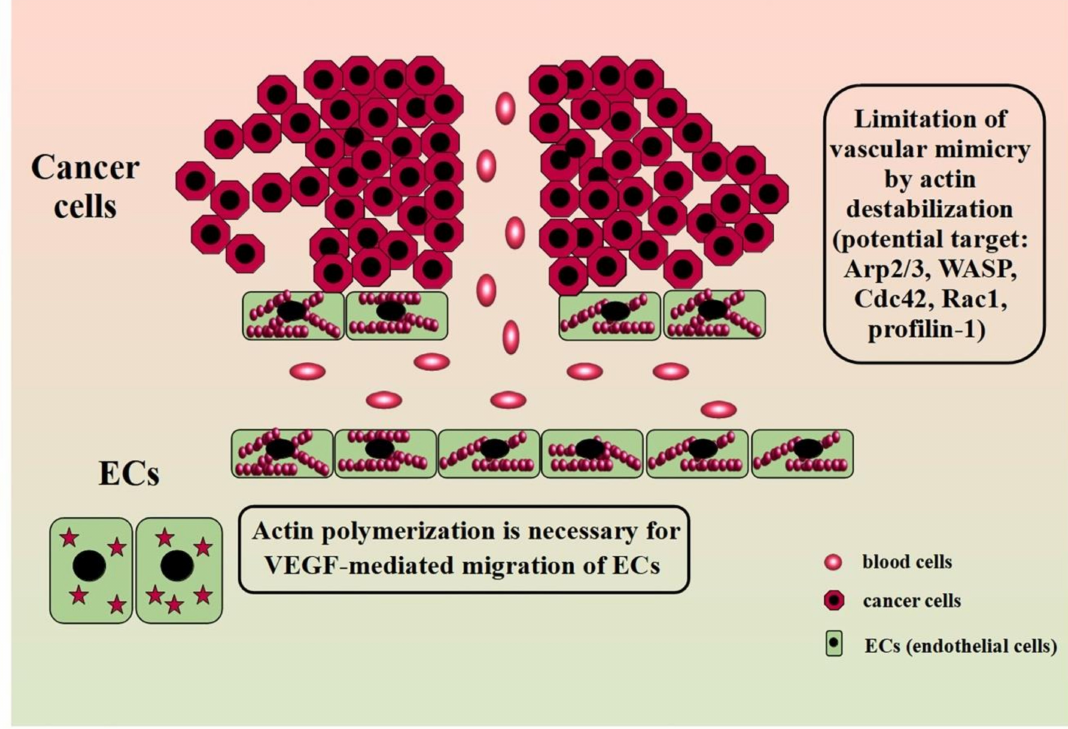
Figure 4. Actin in angiogenesis and vascular mimicry and ABPs as a potential therapeutic target. Modified on the basis of Lugano et al. (2020)